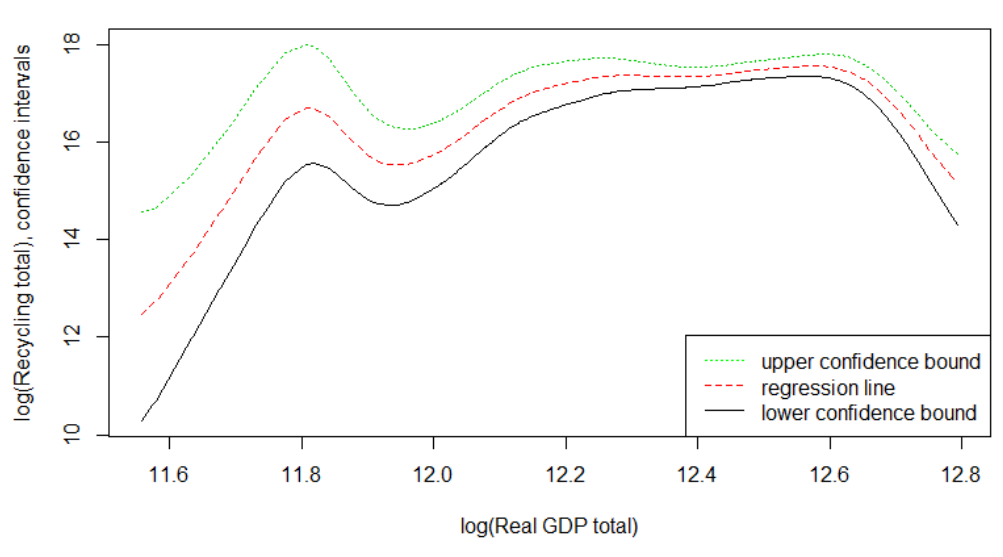
Figure 7. Relationship between log of total Recycling and log of total Real GDP for middle rich states.